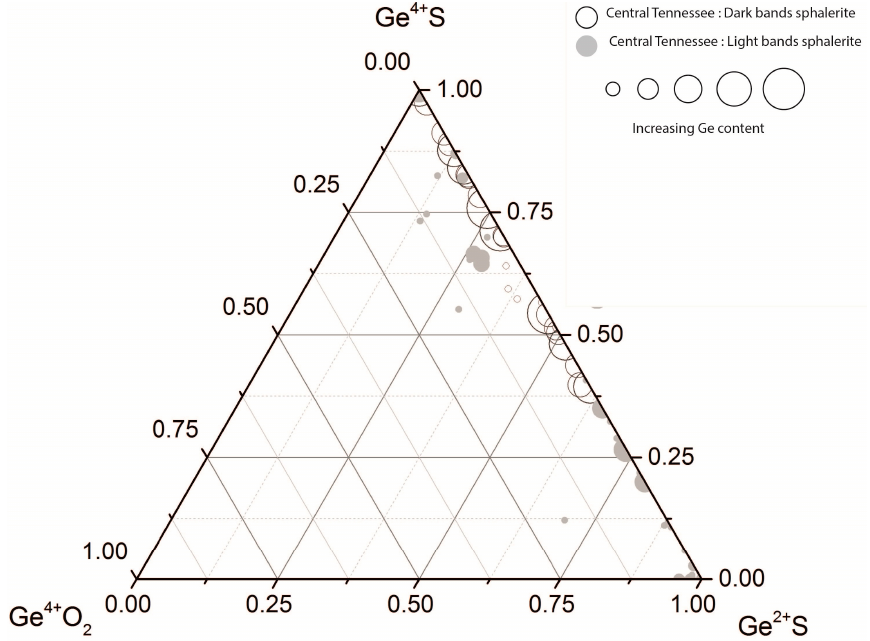
Figure 6. Ternary diagram for germanium configuration in samples from central Tennessee.